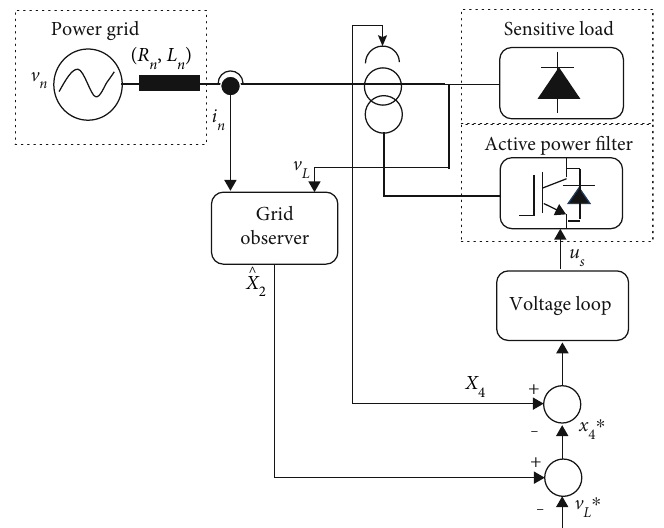
Figure 2: Grid observer and nonlinear controller associated to the series active power fi